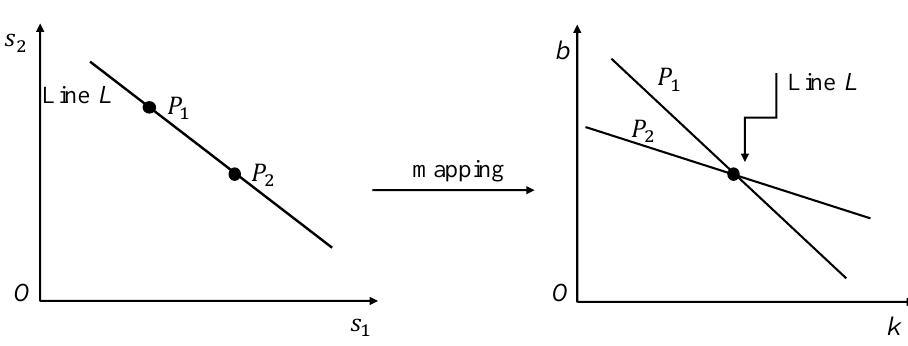
Figure 1. Mapping of 𝑃 1 and 𝑃 2 from Cartesian space to the slope-intercept parameter space.